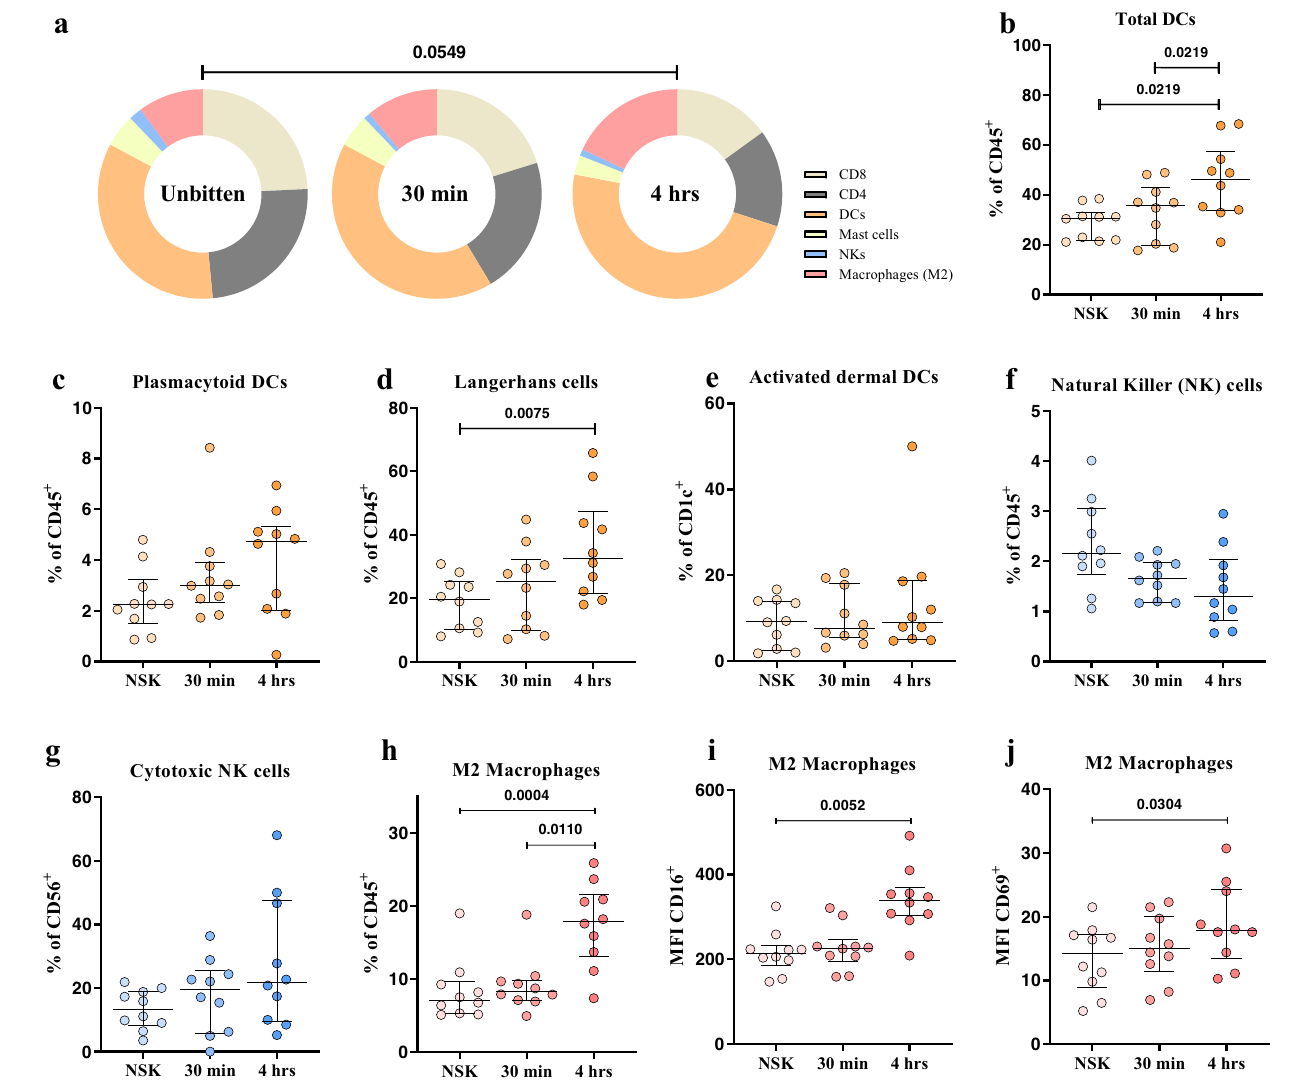
Fig. 5 | Early innate immune responses in the skin are characterized by increased proportions of DCs and M2 macrophages, and a decreased propor- tionofNKcellsat4hpost-bite.a Piechartsshowingchangesinthefrequenciesof skinimmunecellsduringearlyinnateimmuneresponsetomosquitobiteat30min and4hafterexposure.Frequenciesarereportedaspercentagesoftotalleukocytes (CD45 + ). b Total frequency of dendritic cells calculated as the sum of Langerhans (CD207 + ), dermal (CD1c + ), and plasmacytoid (CD123 + ) DCs. c , d Frequency of plasmacytoid dendritic cells and Langerhans cells populations reported as per- centage of total CD45 + cells shows signi fi cant increase of the latter, at 4h post